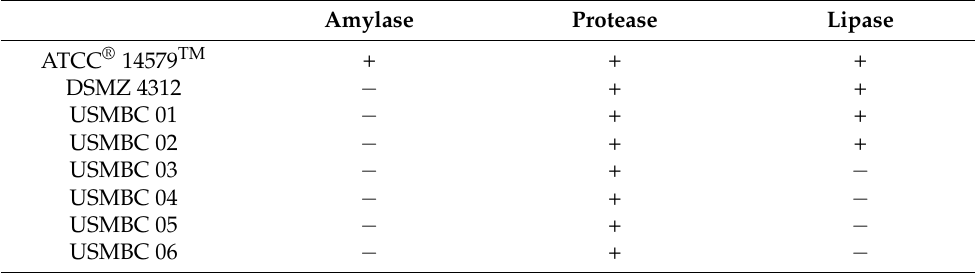
Table 4. Nutritional characteristics of B. cereus strains.